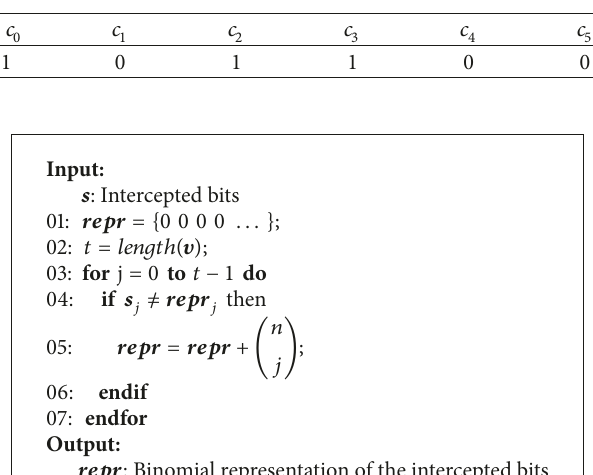
Table 6: Coefficients in Example 21.